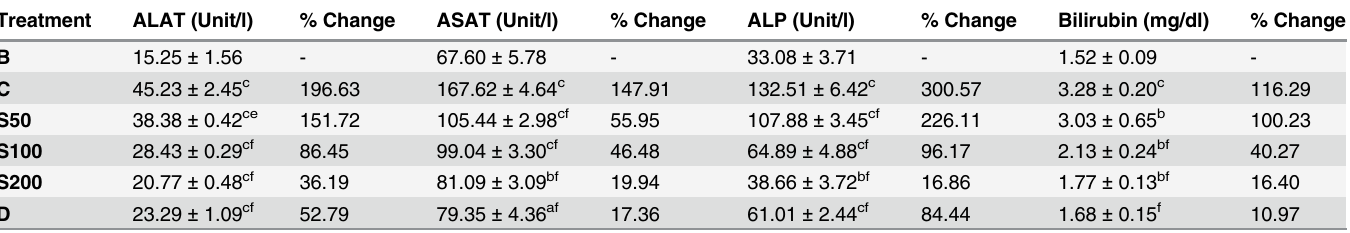
Table 2. The effect of DBME on serum markers (ALAT, ASAT, ALP, bilirubin) in iron overloaded mice. Treatment ALAT